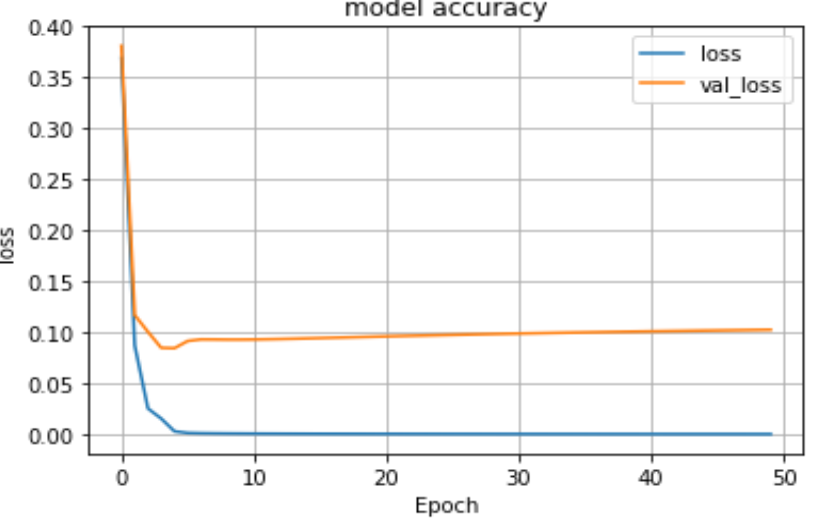
Figure 6. C3-enabled CNN LSTM model accuracy.